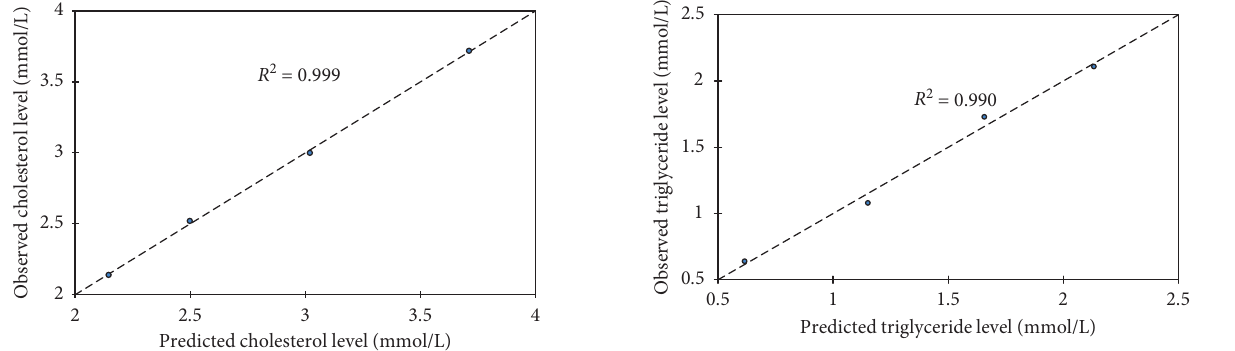
Figure 7: Predicted total cholesterol level against observed one as a lipid profile parameter, where y � total cholesterol levels and x � Costus afer concentrations served as input values.